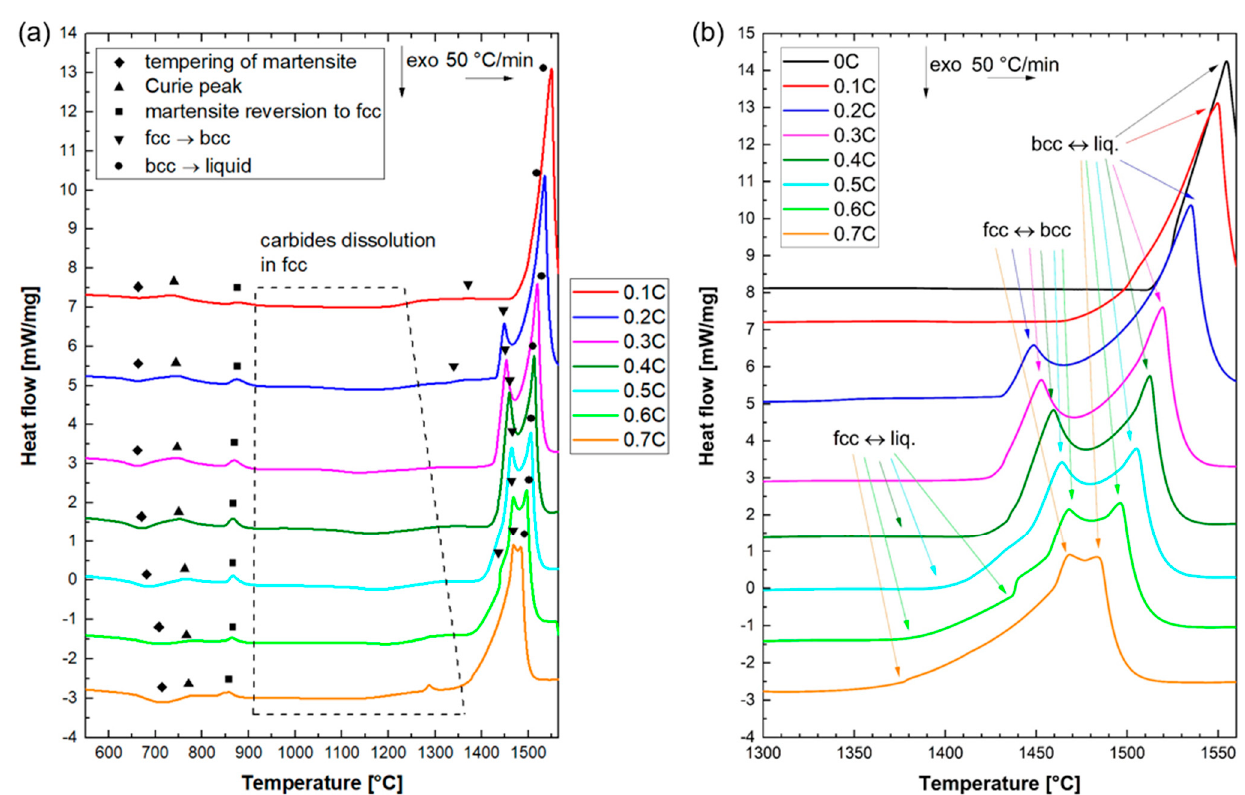
Figure 1. ( a ) DSC results during heating up to 1560 °C; ( b ) an enlarged view of the melting range. Within the temperature range shown in Figure 1b, the binary alloy 0C only exhibits a single endothermic peak, starting at nearly 1510 °C. Based on the optical microstructure of the 0C alloy in Figure 2, this alloy exhibits a fully ferritic microstructure at RT. Accordingly, an inspection of the DSC trace at lower temperatures indicated no peaks other than the endothermic peak, due to the ferromagnetic-to-paramagnetic transition of ferrite (Curie temperature peak, T c ) in the vicinity of 730 °C. In the absence of phase transformations in the solid state, the peak centered about 1550 °C is due to the melting of ferrite and indicates ferritic solidification during the reverse process of cooling from the liquid range.